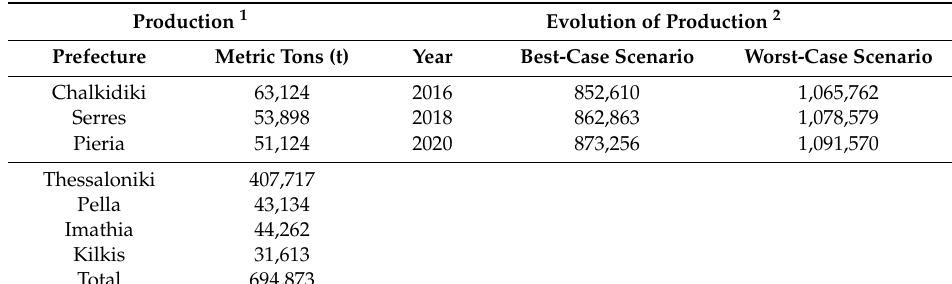
Table 1. Municipal solid wastes (MSW) production, projection and composition* in Central Macedonia region (data for 2014) (data compiled and derived from